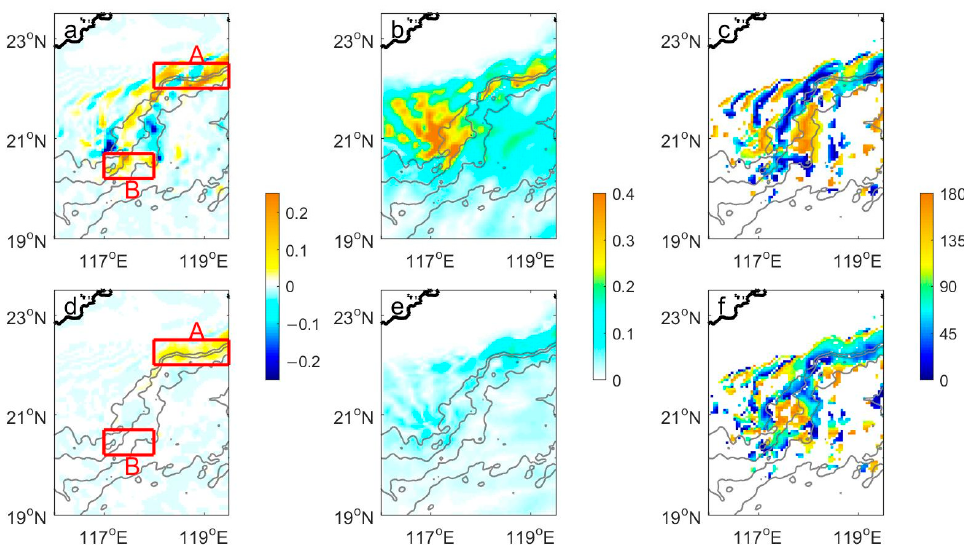
Figure 6. Snapshots of ( a ) the zonal baroclinic currents along 21° N and ( b ) the meridional baroclinic currents along 119° E (shading, unit: m/s) at the end of the simulation.